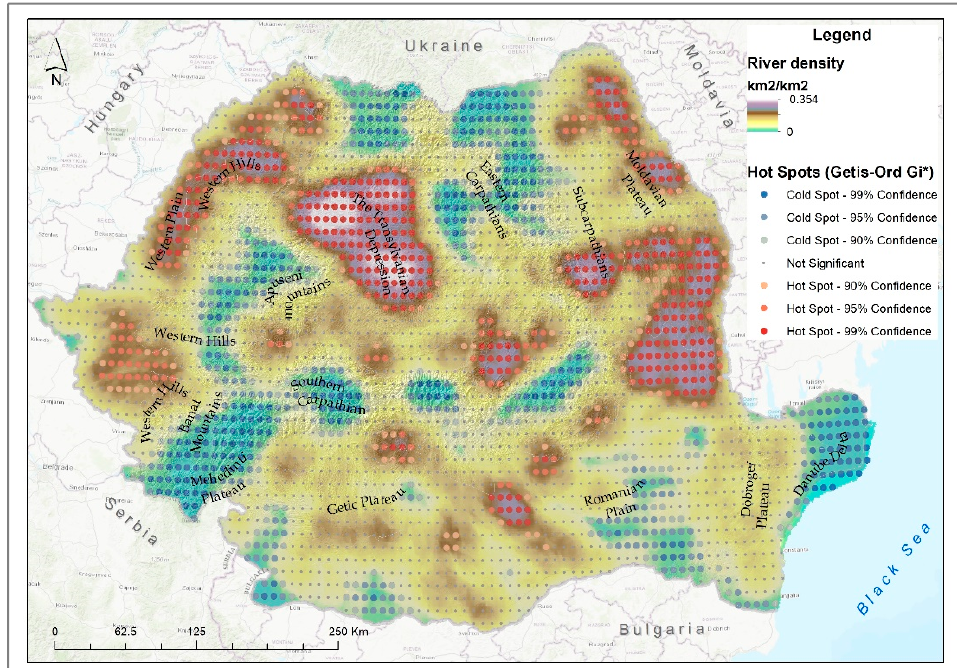
Figure 7. River degraded ecosystem density and hotspot analysis.